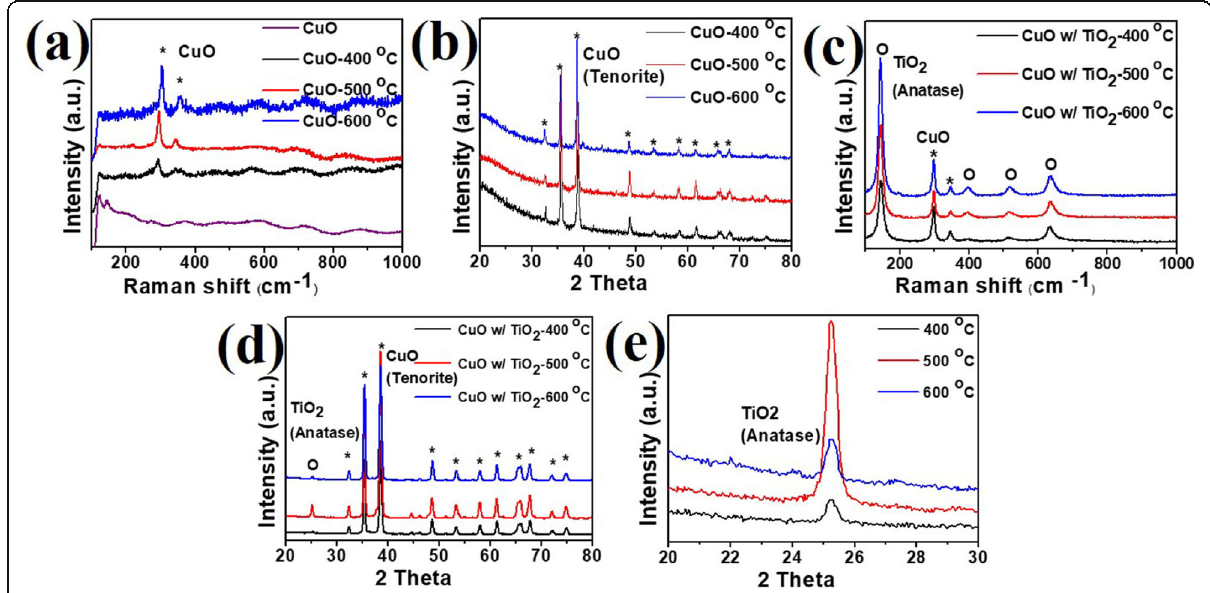
Fig. 3 a Raman and b XRD results of CuO NRs annealed at different temperatures. c Raman and d XRD results of CuO/TiO 2 annealed at different temperatures. e The magnified view of the XRD results for CuO/TiO 2 at 2 θ ranges of 20 –